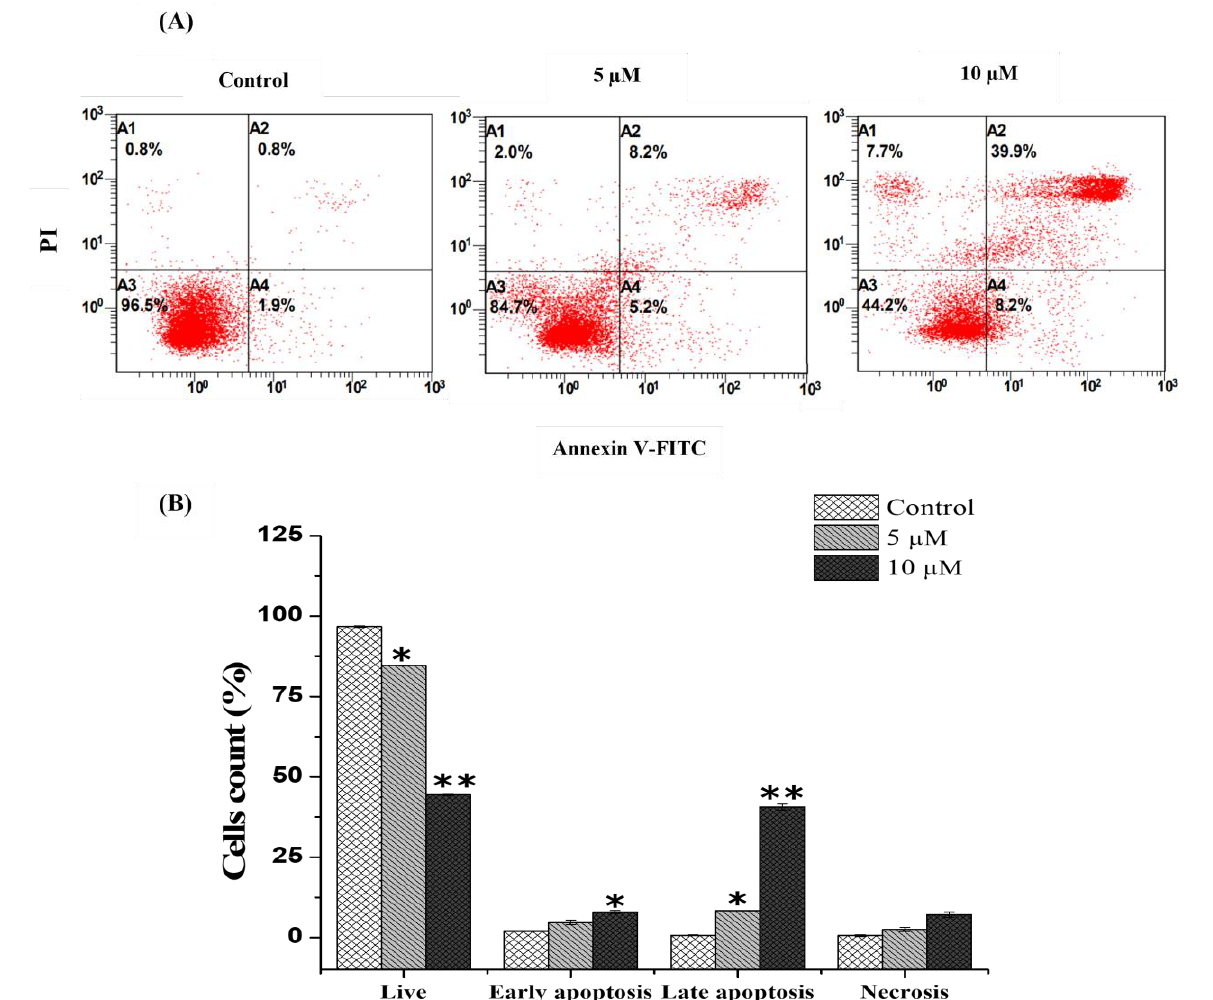
Figure 3. Effect of chlorojanerin on the apoptosis induction of A549 cells. A549 cells were treated with chlorojanerin for 24 h at 5 and 10 μM. ( A ) Annexin V-PI double staining histogram showing cell apoptosis. ( B ) Quantitative data of live, early and apoptotic cells and necrotic apoptotic cells. * p < 0.05; ** p < 0.01 vs. untreated control.